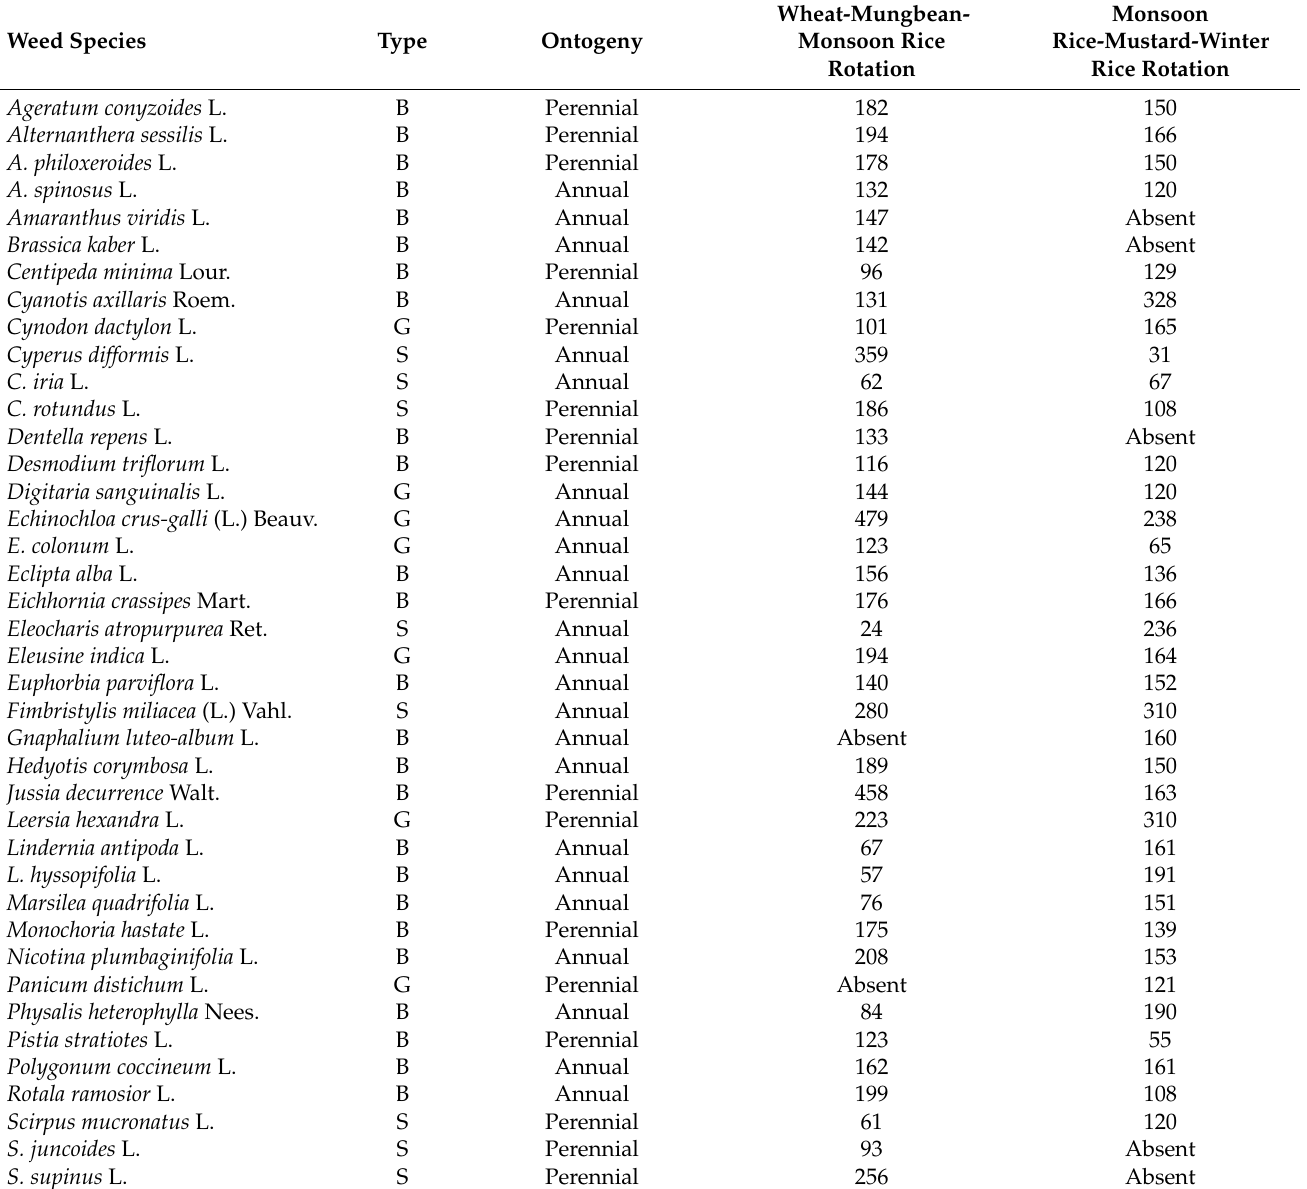
Wheat-Mungbean- Monsoon Monsoon Rice Rice-Mustard-Winter Rotation Rice Rotation